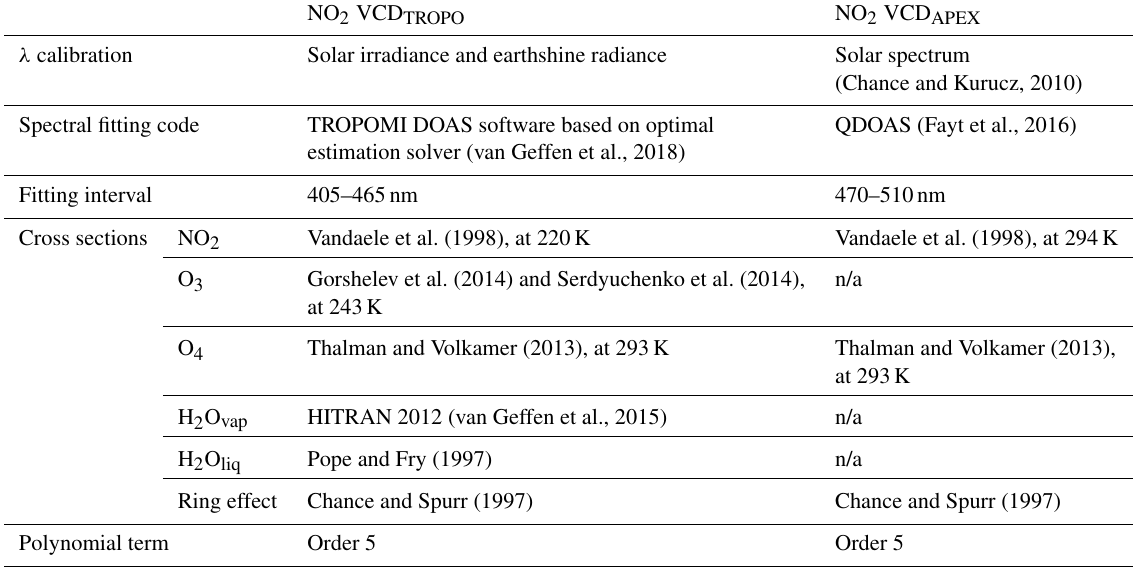
Table 3. Overview of the key parameters for the DOAS spectral fitting and NO 2 slant column